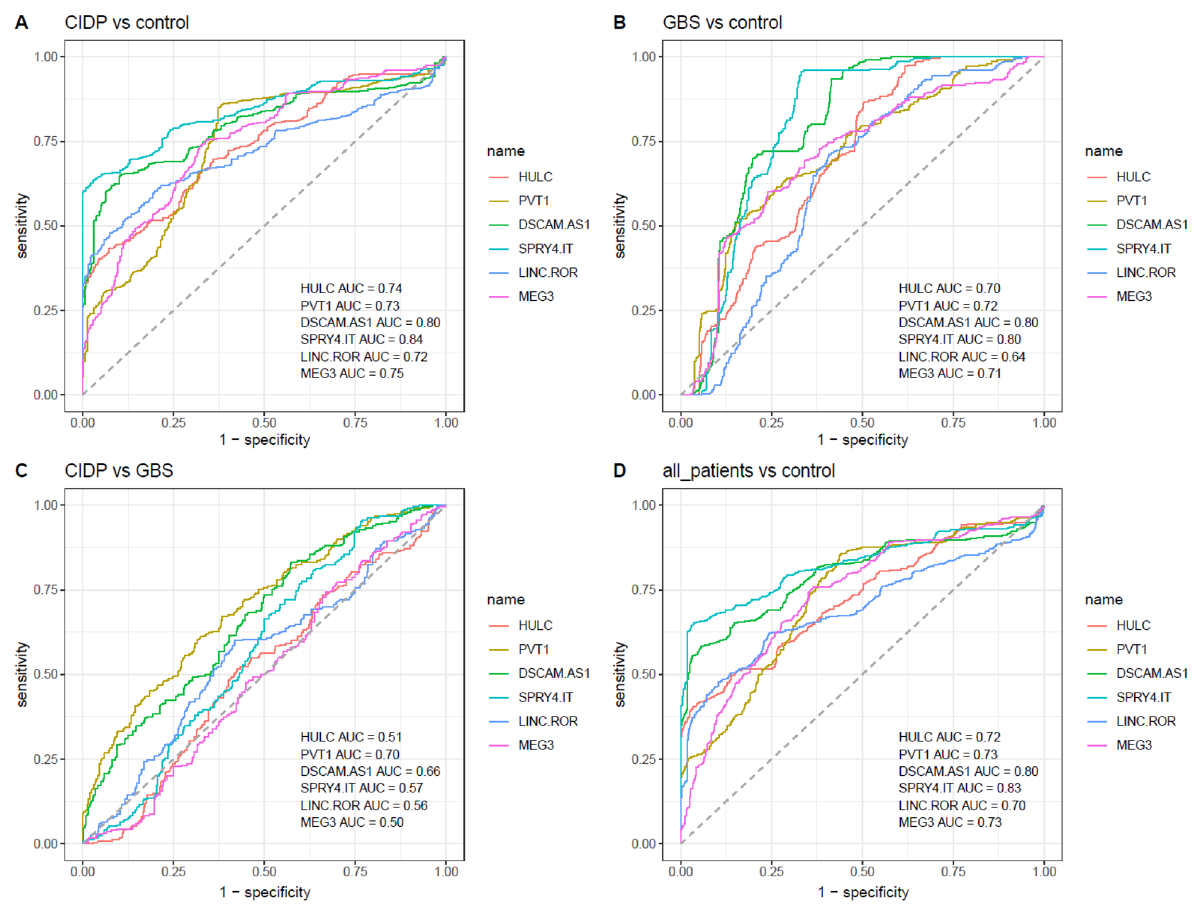
Figure 4. ROC curves showing the diagnostic power of lncRNAs in differentiation of CIDP cases from controls ( A ), GBS cases from controls ( B ), CIDP cases from GBS cases ( C ), and total patients from controls ( D ).